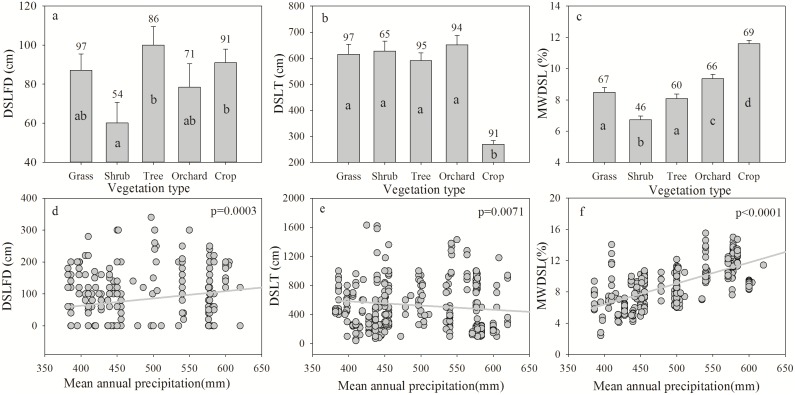
Dry soil layer formation depth (DSLFD), dry soil layer thickness (DSLT) and mean water content of the dry soil layer (MWDSL) for vegetation types and relationships with mean annual precipitation.The lowercase letters within the vertical bars indicate significant differences at α = 0.05 according to the LSD test.